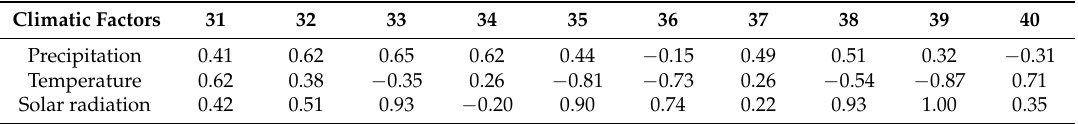
Table 3. The partial correlation coefficients between grassland NPP and climate